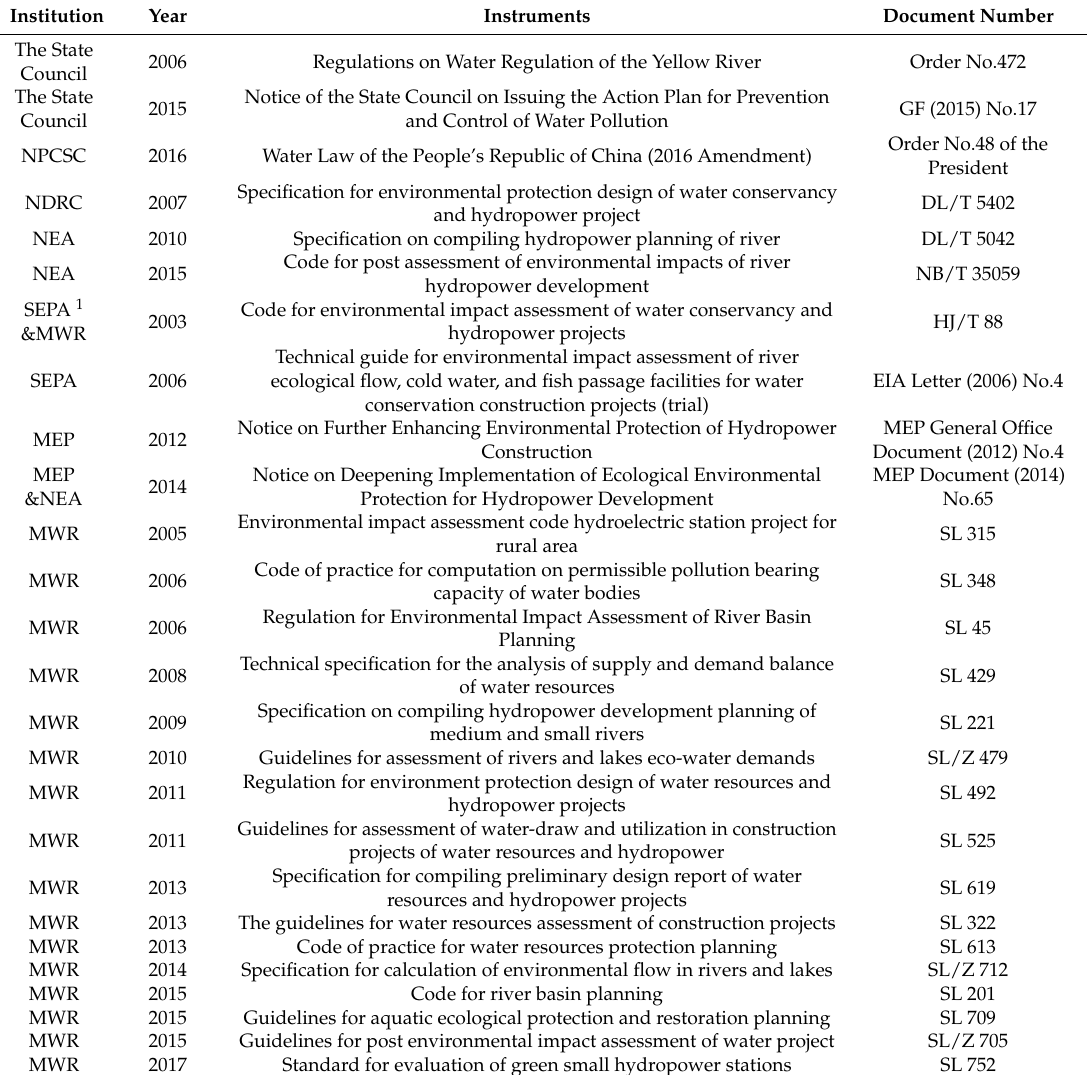
Table 2. Regulations, guidelines and codes on e-flows in